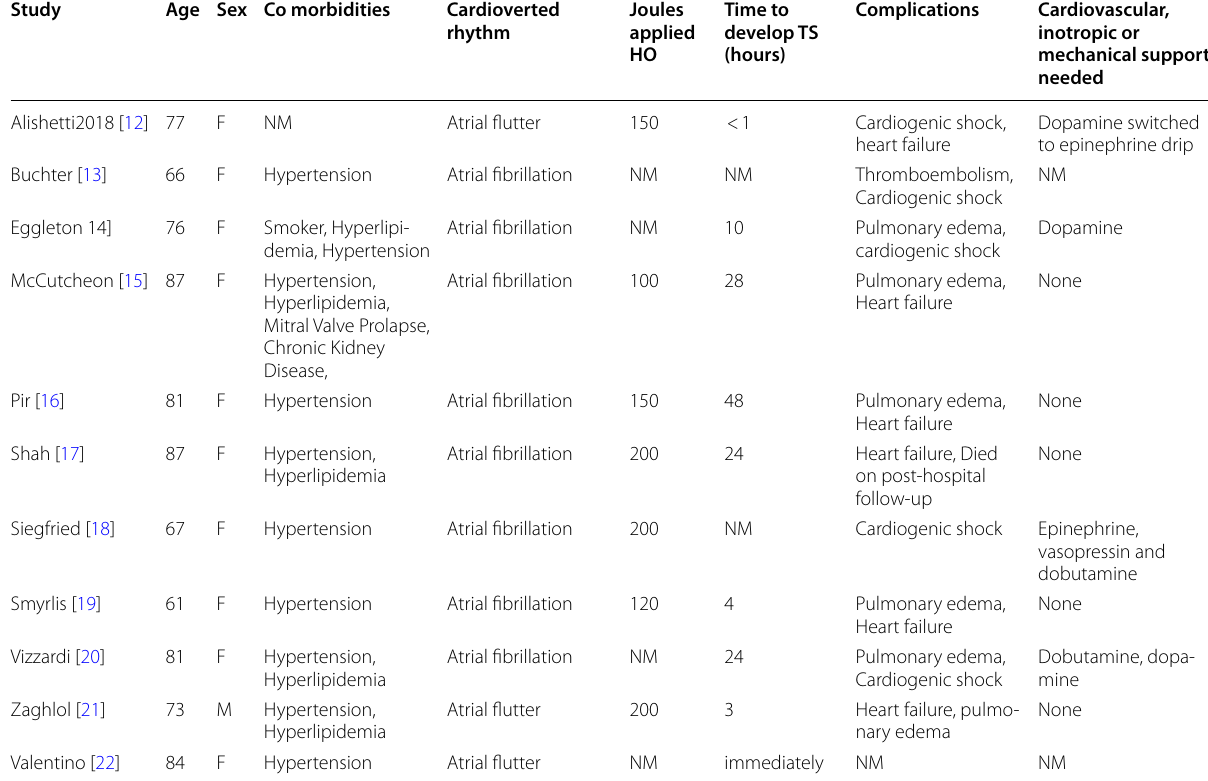
Table 1 Patient demographics and disease characteristics, NM: not mentioned